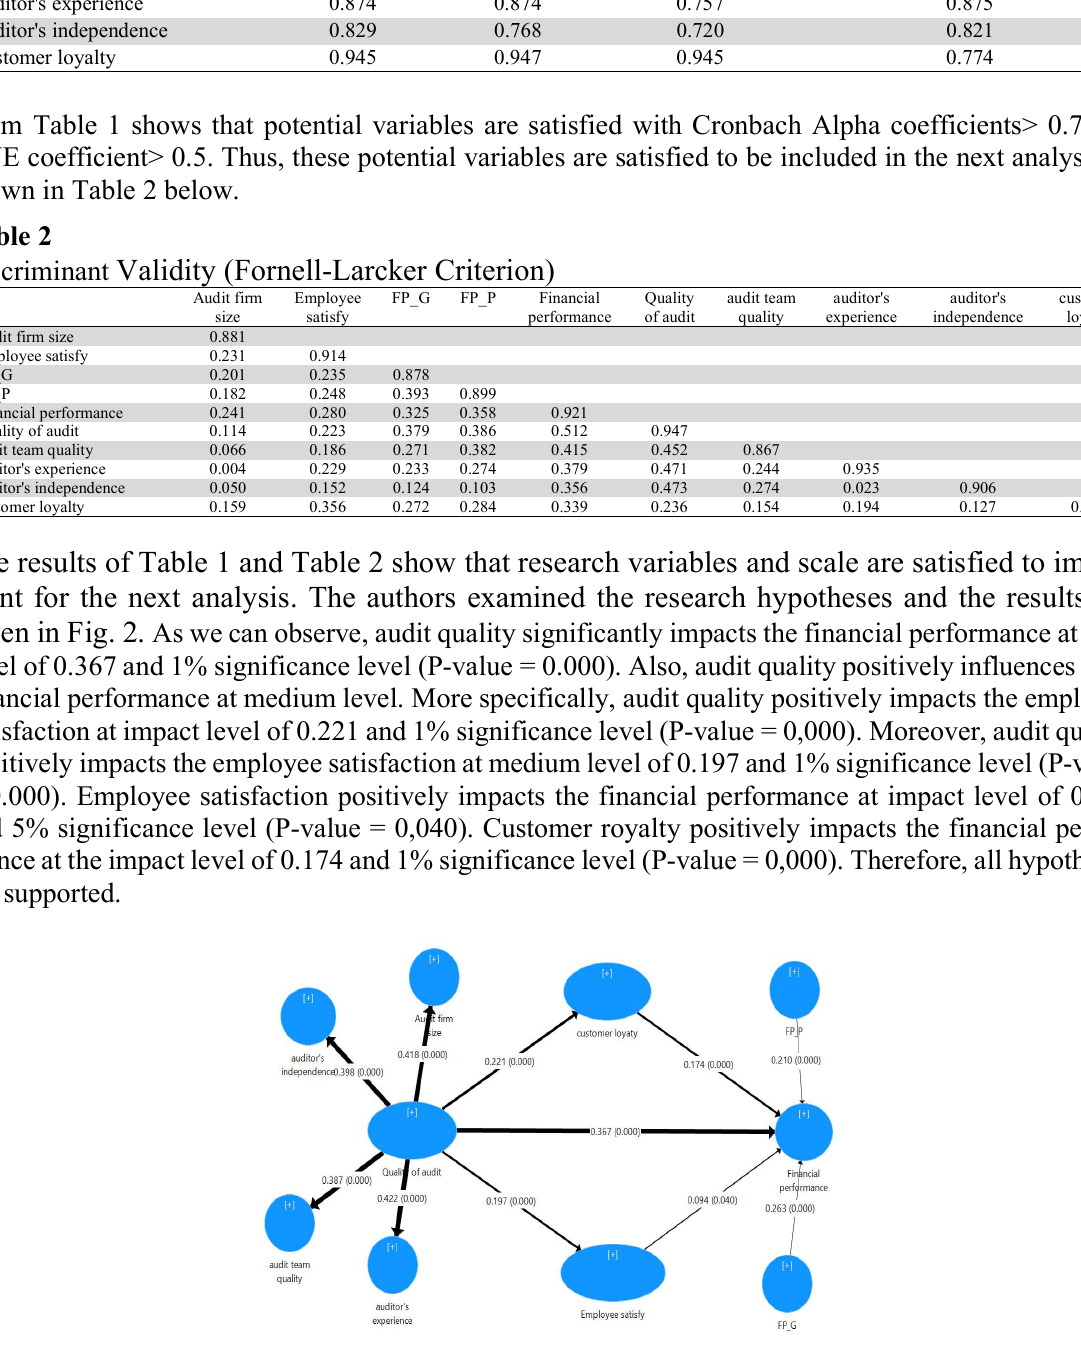
Fig. 2. Result of testing the